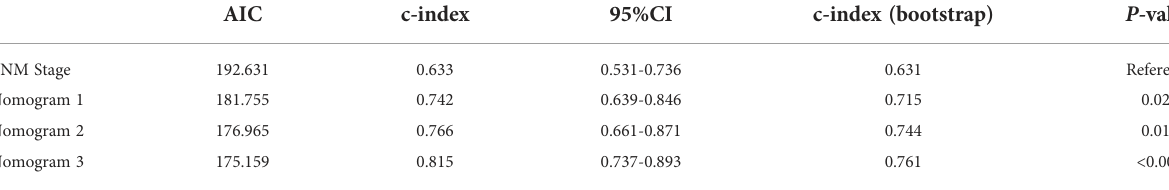
TABLE 3 Performances of current TNM staging system and proposed